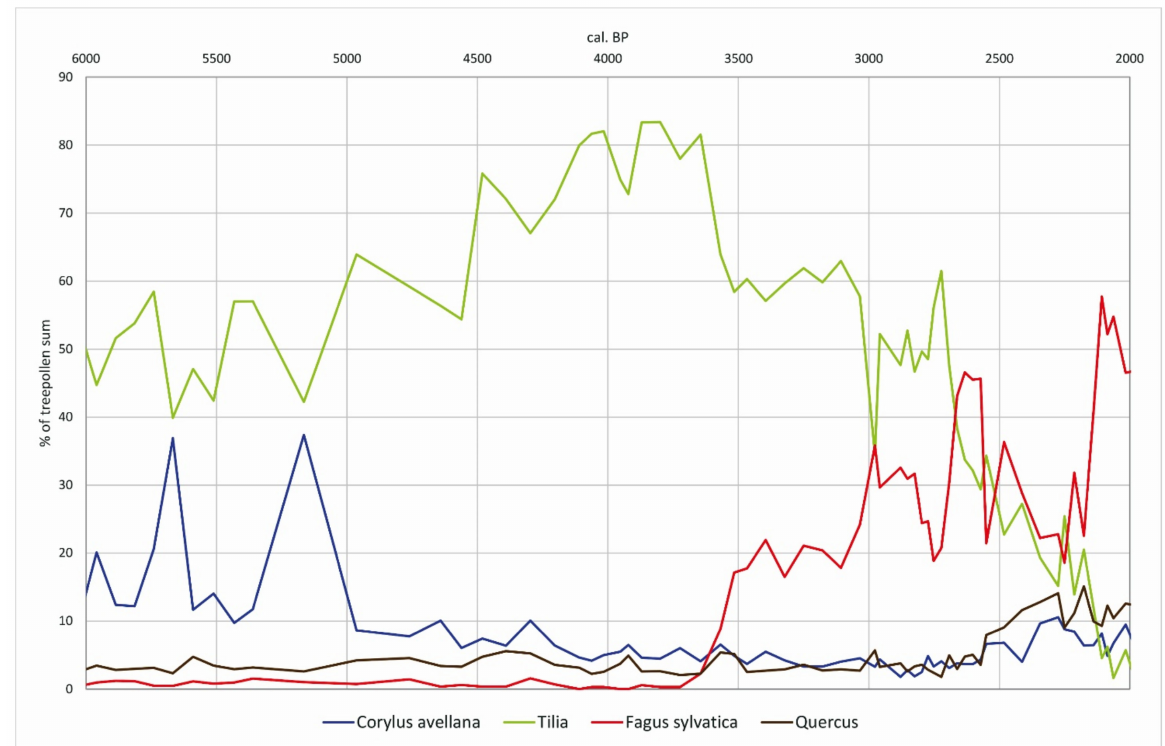
Figure 7. Pollen percentages transformed by R values of selected tree taxa at profile